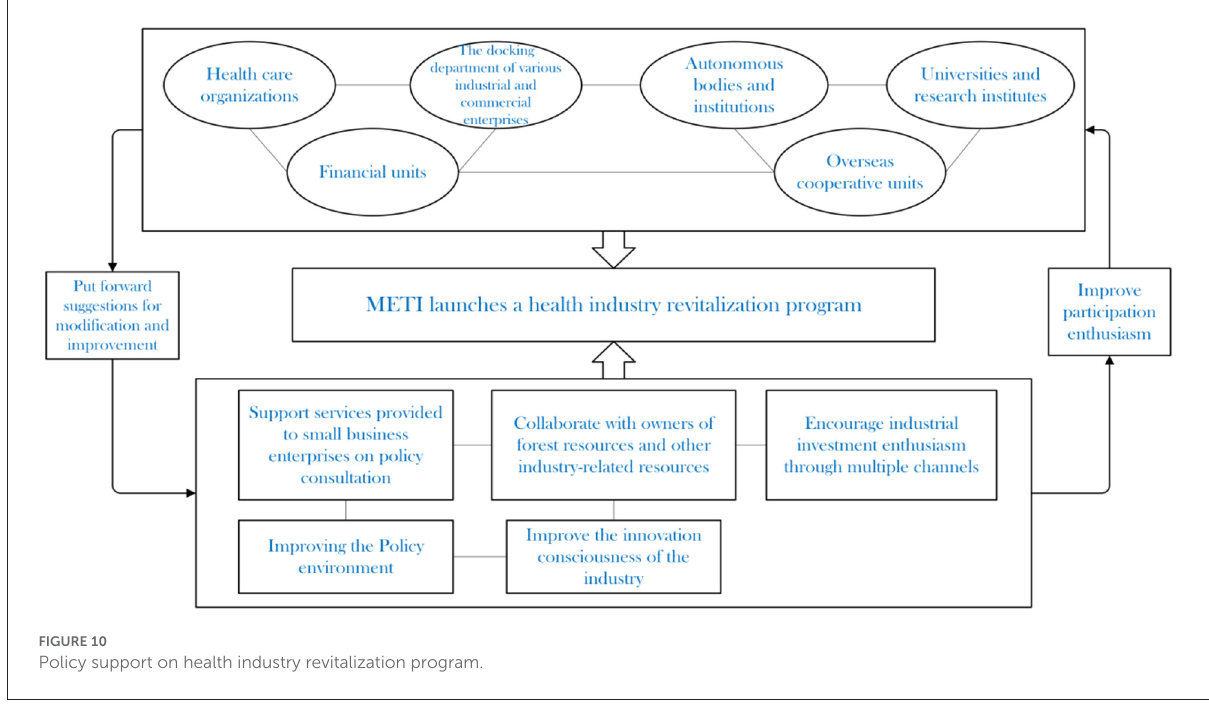
FIGURE10 Policy support on health industry revitalization program.